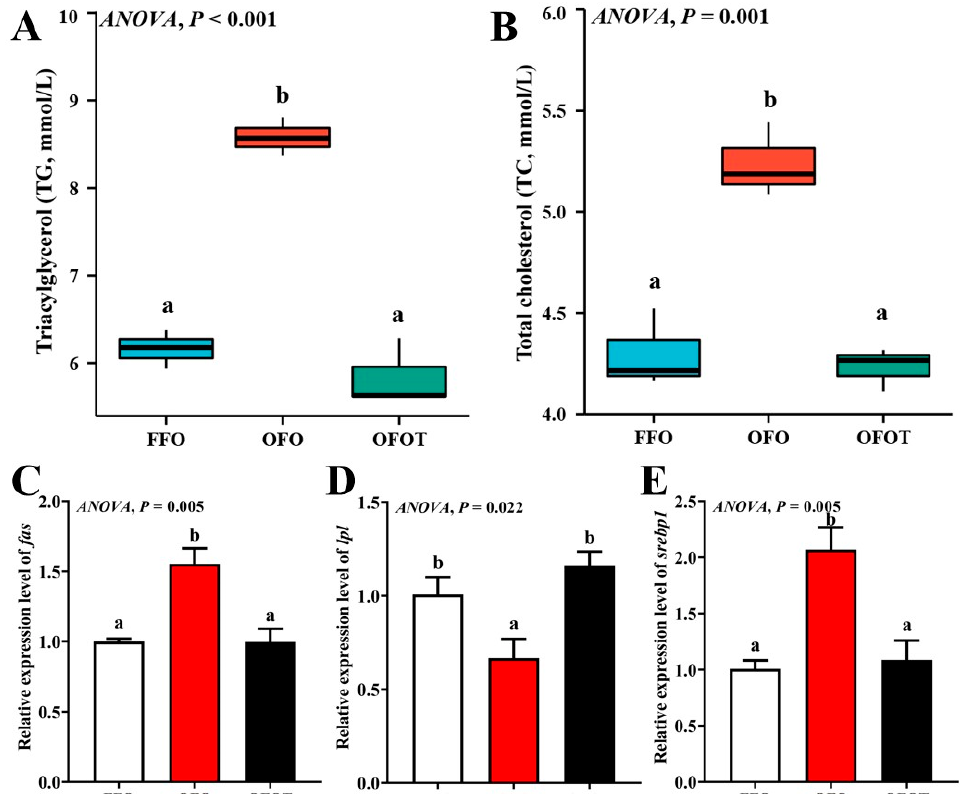
Figure 1. Serum biochemical indices and lipid-metabolism-related gene expression of the liver in channel catfish ( Ictalurus punctatus ) fed the diets. ( A ) Triacylglycerol, TG; ( B ) total cholesterol, TC; and ( C – E ) lipid-metabolism-related genes ( fas , acc, and srebp1 ). Data indicate the mean values of three replicate cages per treatment (three fish per replicate breeding barrel). Significance was evaluated by one-way ANOVA ( p < 0.05) followed by Duncan’s multiple range tests. Values marked with different letters are significantly different between the treatment groups.